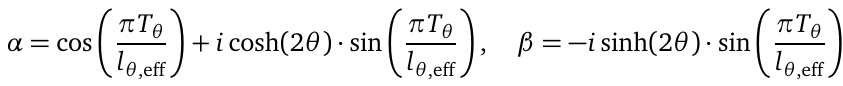
Figure 5: Lyapunov exponents λ N = 2 (left) and N = ∞ (right) driving Hamiltonians, respectively. For N = 2, we choose the two driving Hamiltonians as H θ = and 0.25, respectively. The probabilities are p the Hamiltonians as H θ with θ uniformly distributed in [ 0, θ 0.15, 0.2, and 0.25, respectively. For both cases, we take the ensemble average over = N sample